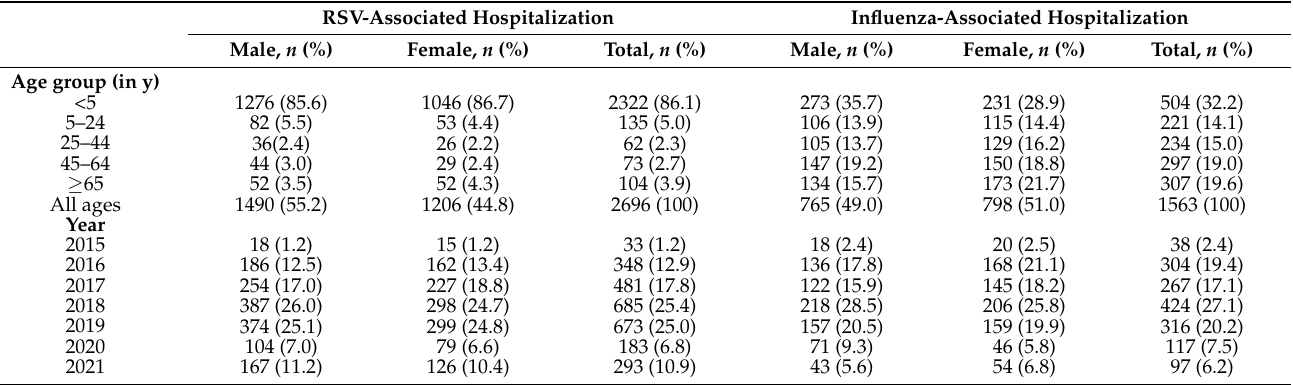
Table 1. Cases of respiratory syncytial virus and influenza associated with hospitalization in Peru,